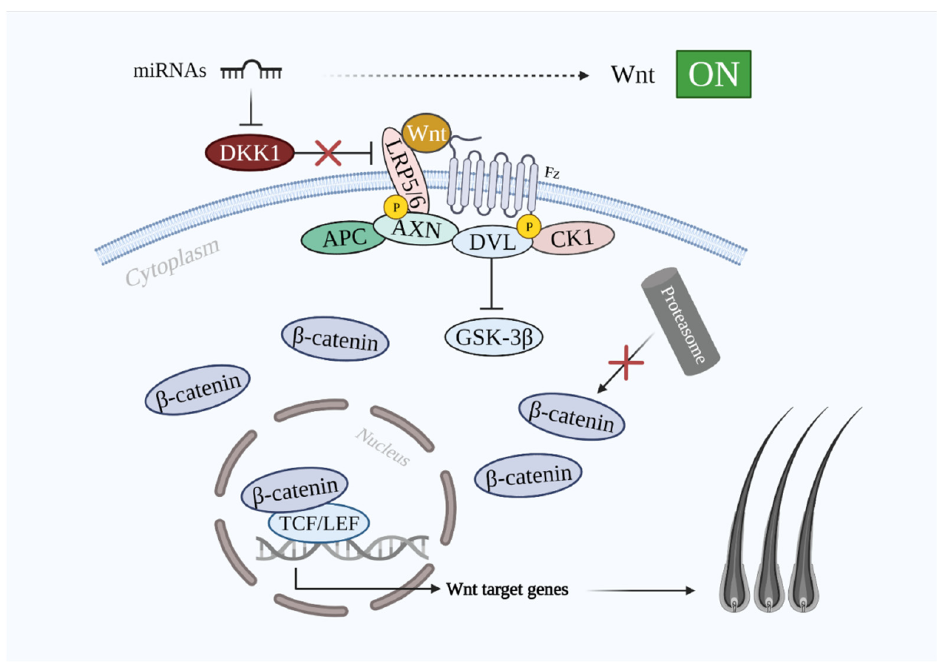
Figure 6. Schematic illustration of miRNAs role in hair growth. miRNAs targeting DKK1 allow Wnt to bind LRP5/6 and Fz to activate the signaling pathway and promote hair growth. Abbreviations: DKK1, dickkopf-related protein 1; Wnt, wingless and integrated-1; Fz, frizzled; LRP5/6, low-density lipoprotein receptor-related proteins 5/6; GSK-3 β , glycogen synthase kinase 3 β ; CK1, casein kinase 1; DVL, dishevelled; APC, adenomatous polyposis coli; TCF/LEF, T-cell factor/lymphoid enhancer factor.